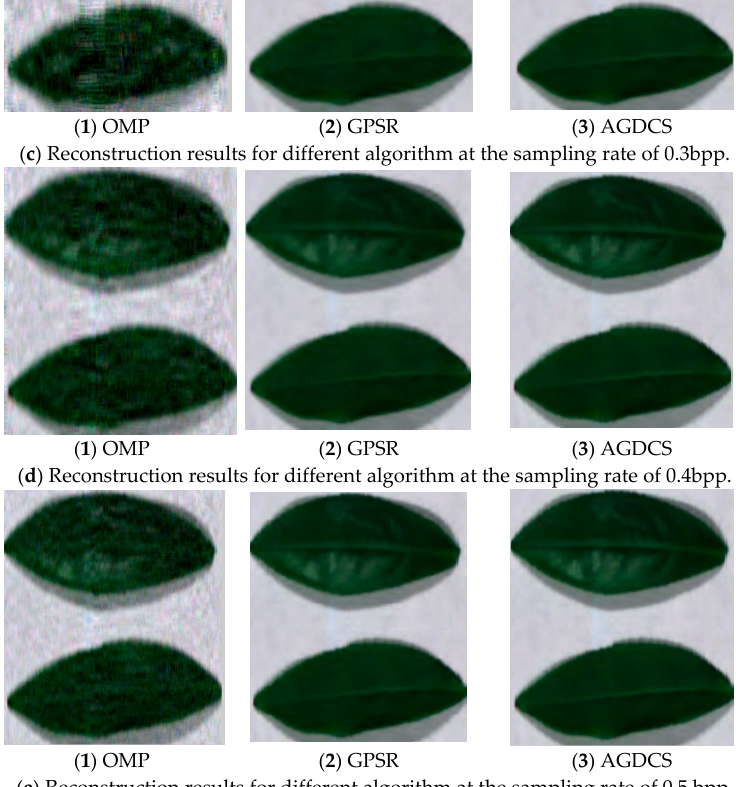
Figure 8. Comparison of reconstruction results for different algorithms at different sampling rates.